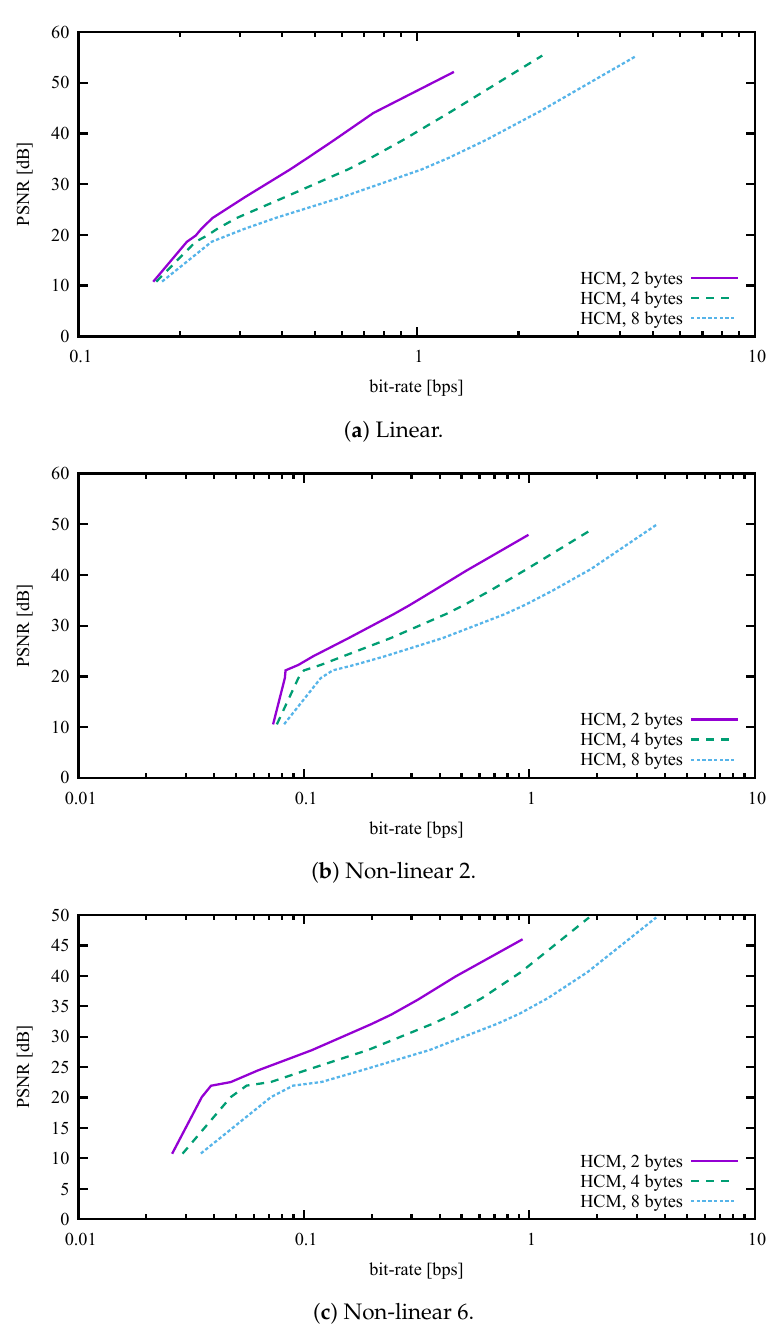
Figure 3. Different variations of the high-intensity focused ultrasound (HIFU) compression methods (HCMs). The average bit rate and the corresponding peak signal-to-noise ratio (PSNR) for testing datasets: ( a ) Linear, ( b ) Non-linear 2, and ( c ) Non-linear